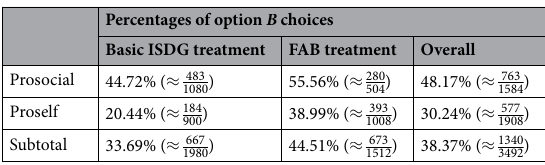
Table 2. The percentages of option B for prosocial subjects in the basic ISDG and FAB